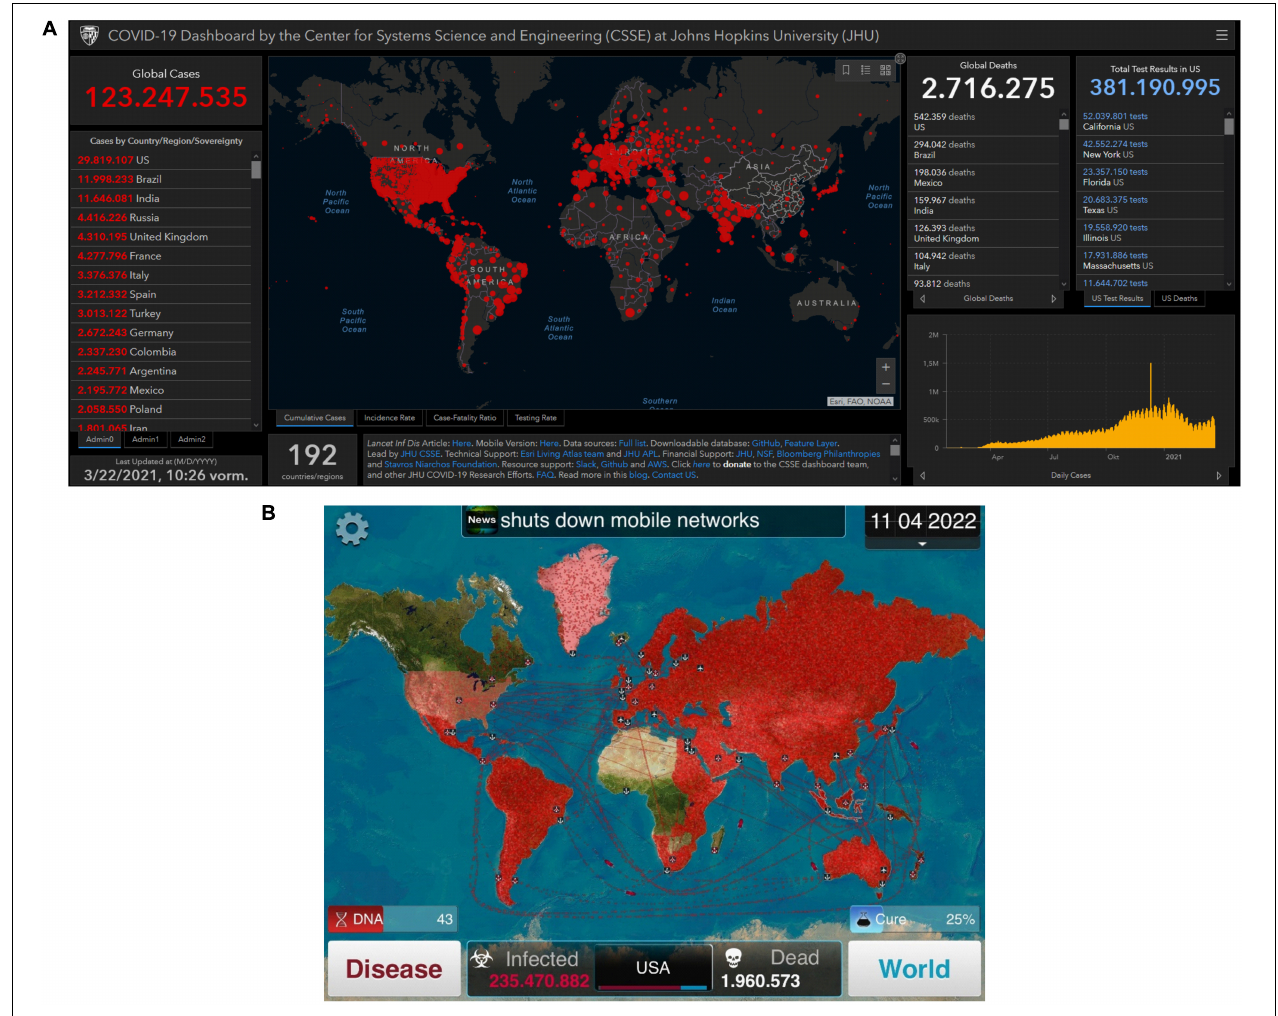
FIGURE 1 | COVID-19 Dashboard by the Center for Systems Science and Engineering (CSSE) at Johns Hopkins University (A) as well as the interface of the game “Plague Inc”